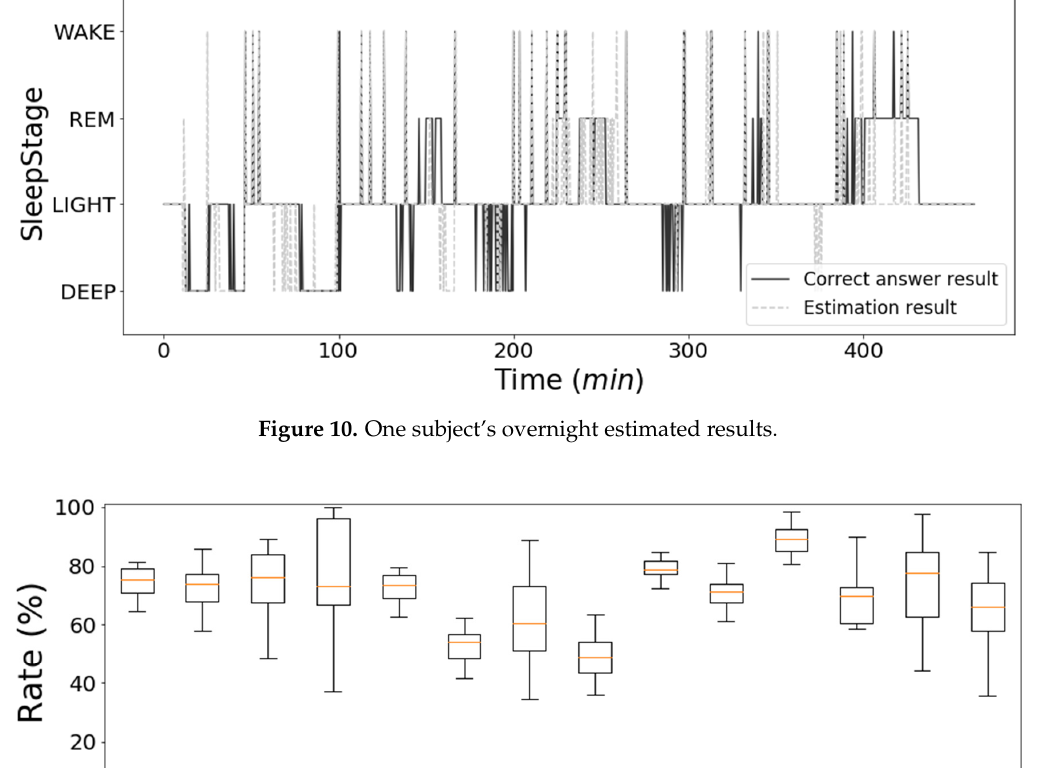
Table 5. Confusion matrix obtained from leave-one-out cross-validation ( n = 15) .